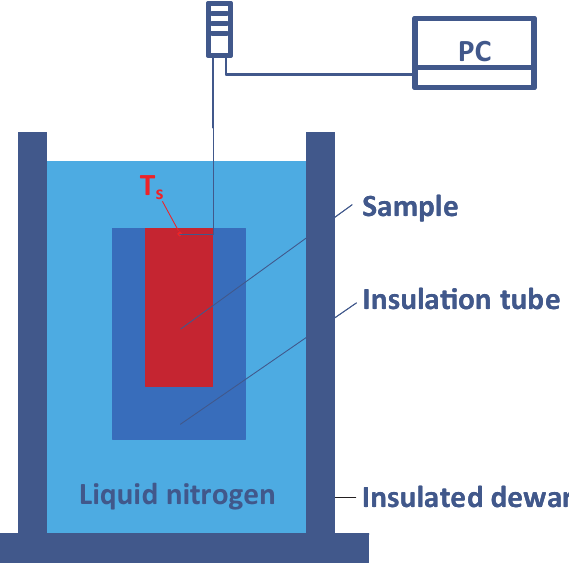
Figure 1. Diagram of the experimental